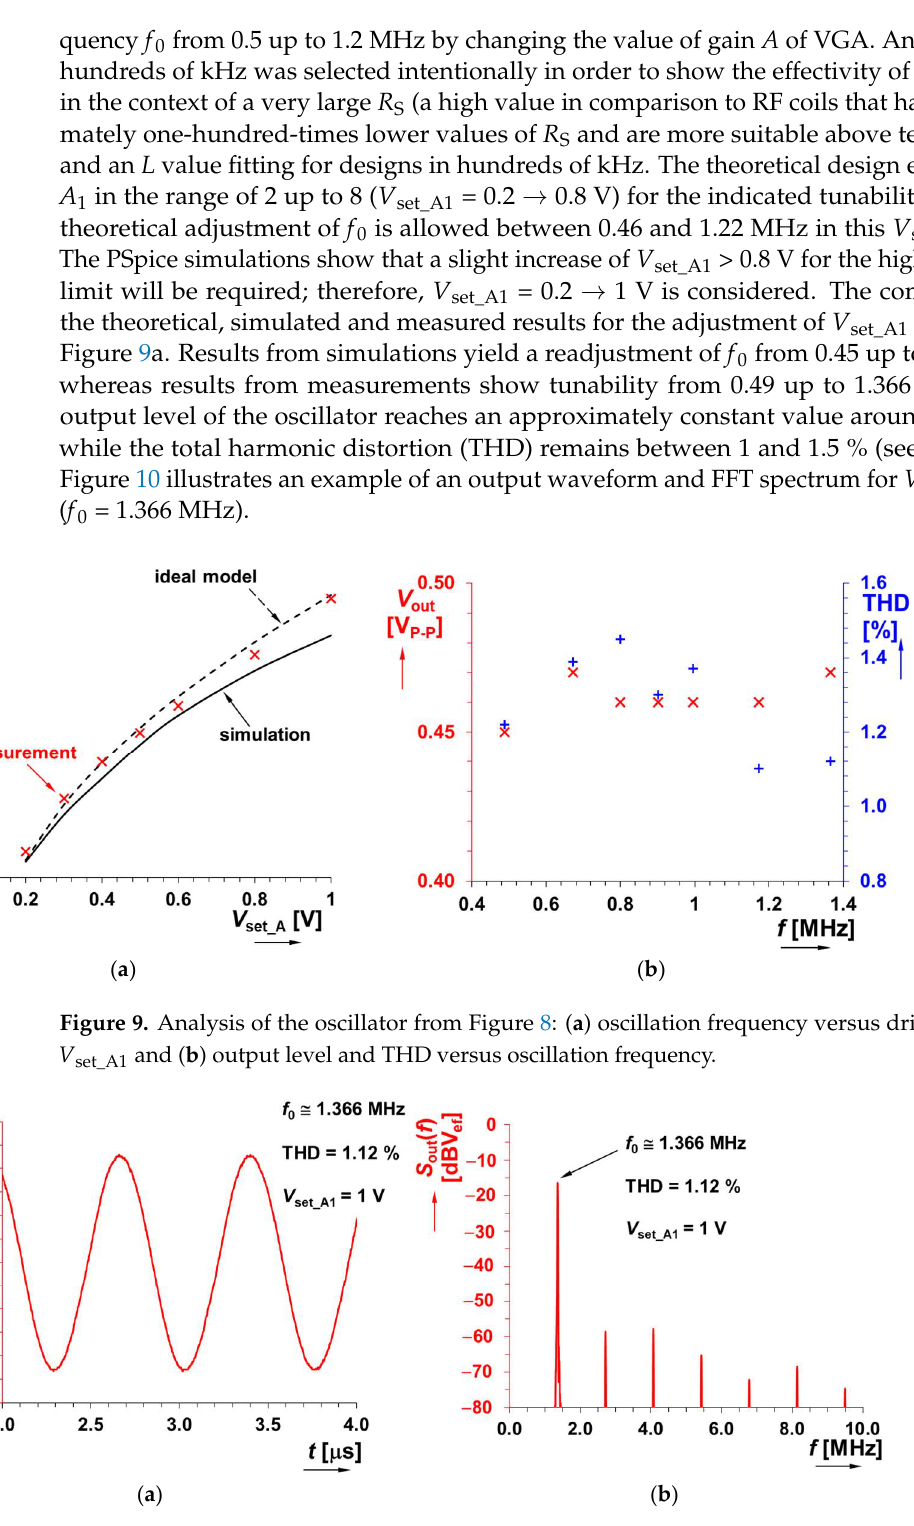
Figure 10. Example of output waveform for V set_A1 = 1 V ( f 0 = 1.366 MHz): ( a ) time domain and ( b ) frequency domain. ( b ) frequency